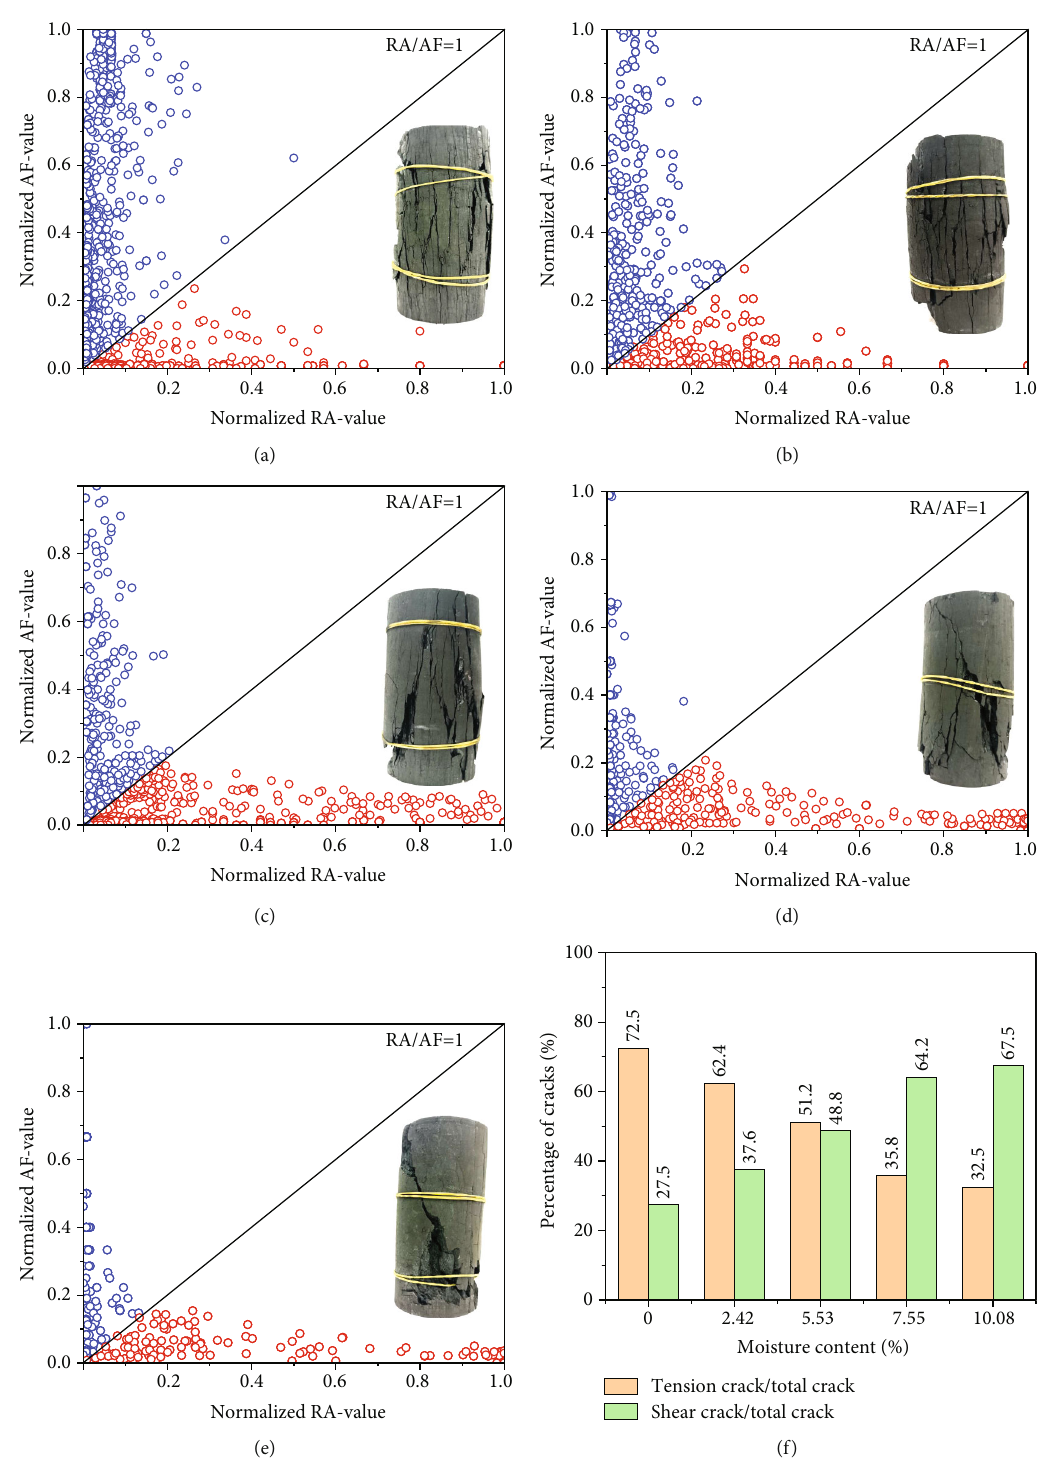
Figure 13: Tensile shear crack evolution law and crack proportion of coal specimens under di ff erent moisture contents: (a) ω = 0 % , (b) ω = 2 : 42 % , (c) ω = 5 : 53 % , (d) ω = 7 : 55 % , and (e) ω = 10 : 08 % . (f) Proportion of